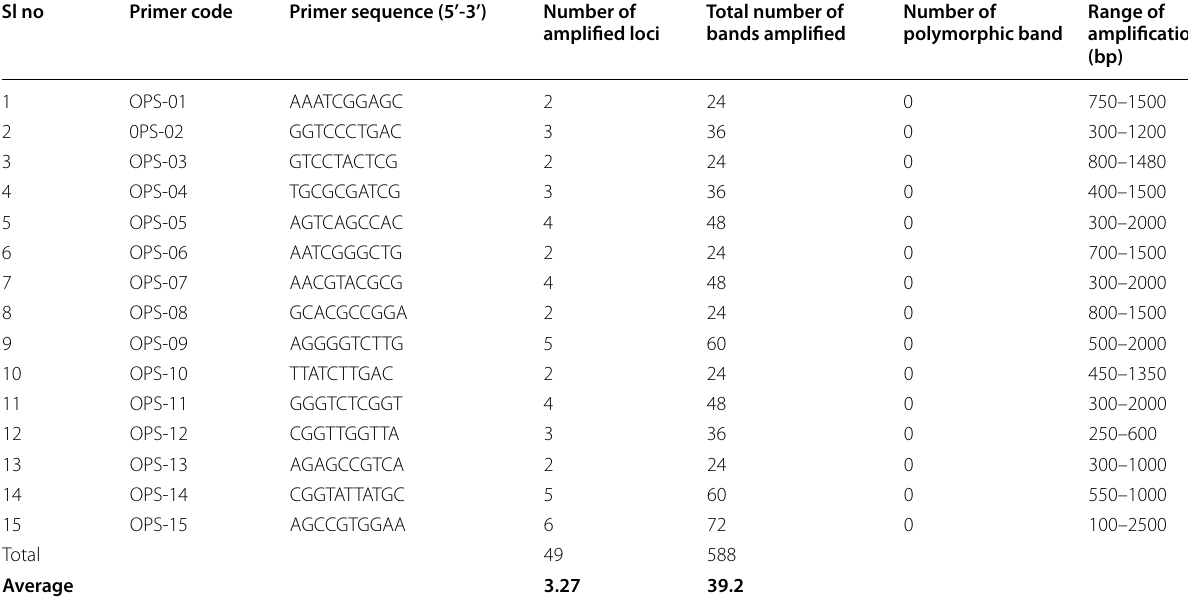
Table 1 List of random amplification of polymorphic DNA (RAPD) primers, their sequence motifs, total number, and size of the amplified loci used for determination of genetic integrity of hardened and mother plants of Artocarpus heterophyllus L